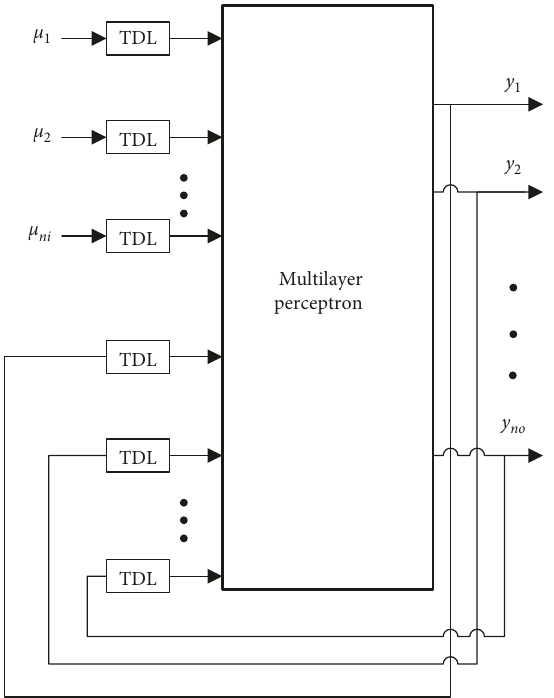
Figure 2: Canonical structure of an NLARX